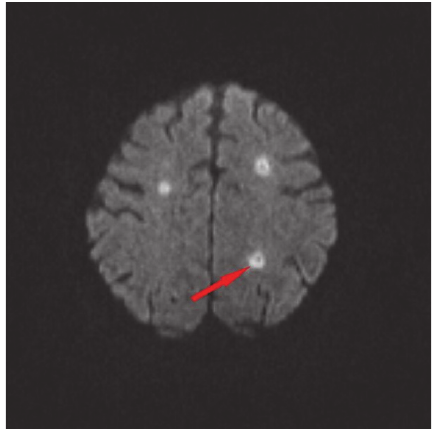
Figure 2: CT scan (coronal image) of the thorax with thrombus adhering to the wall in both internal jugular veins (red arrow).